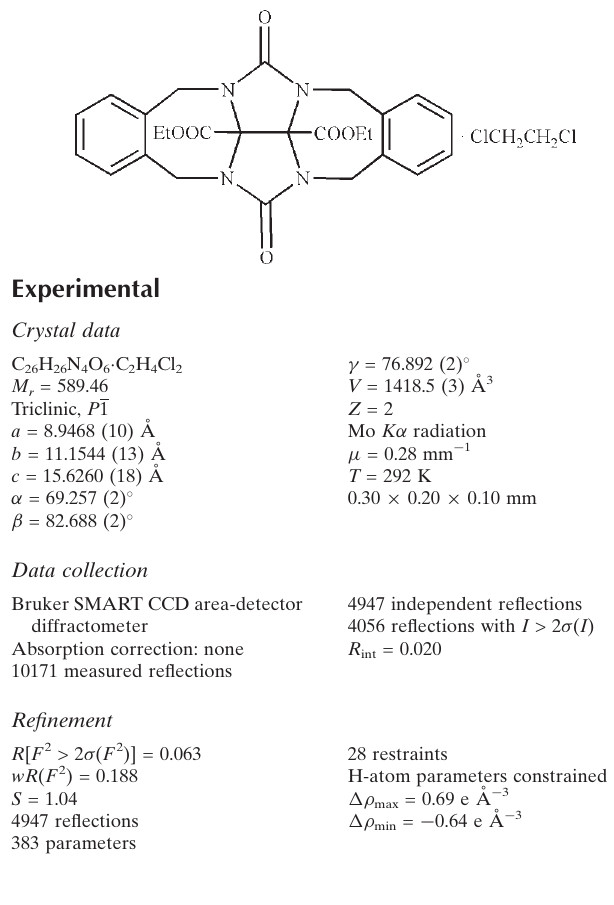
Absorption correction: none 10171 measured reflections